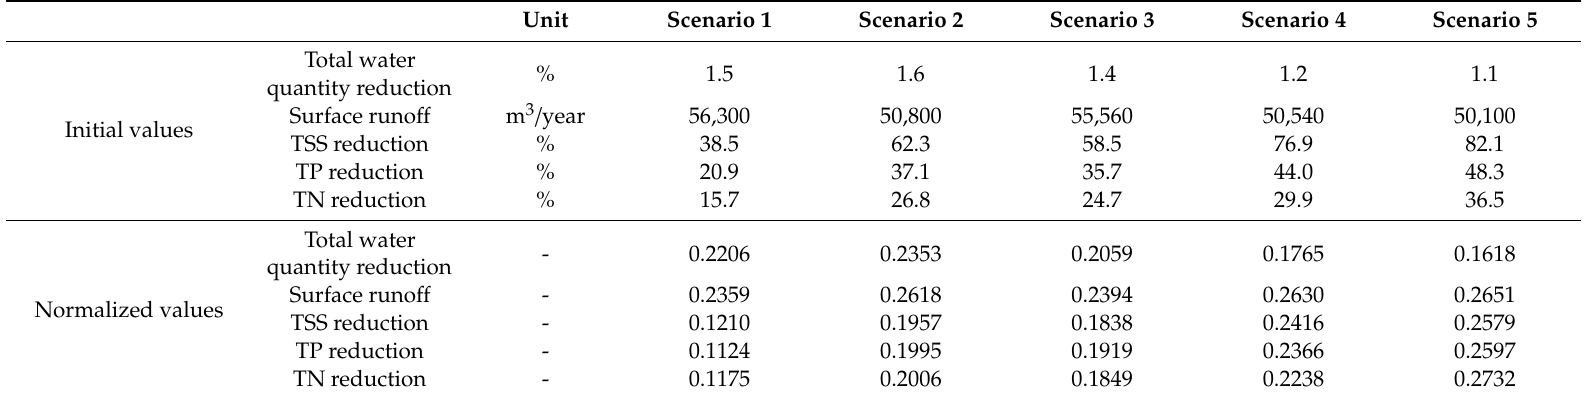
Table 10. The individual and normalized results of the functional aspect.